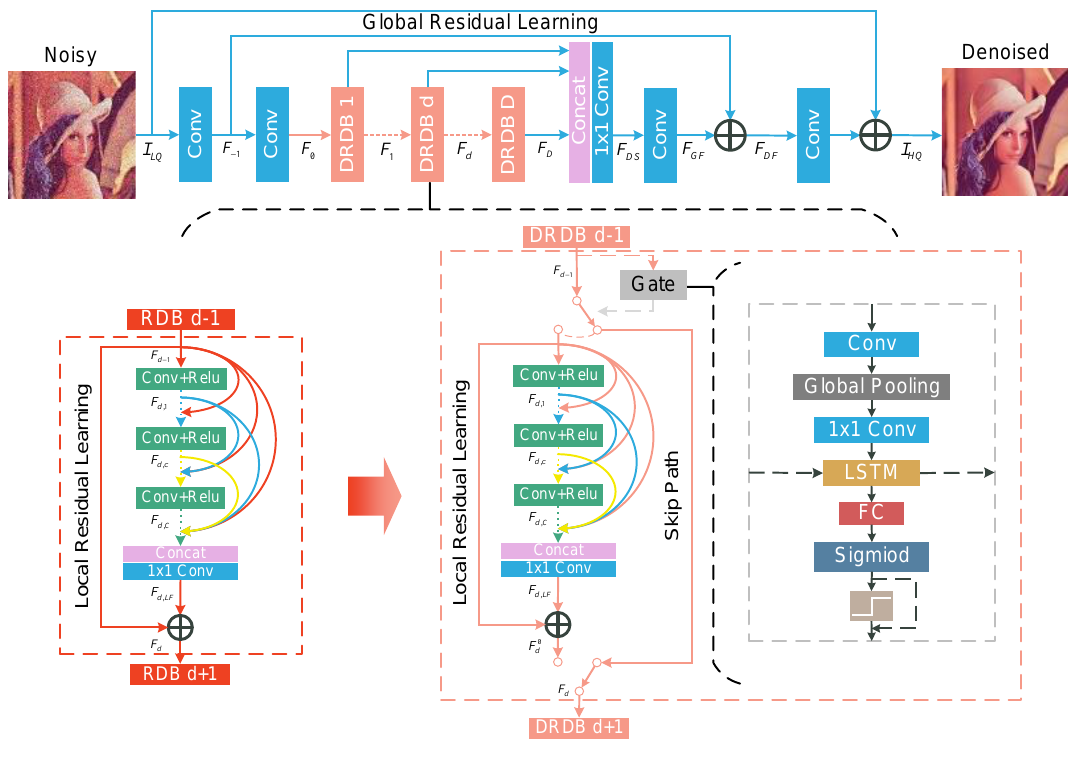
Figure 2. The top part presents the overall architecture of the DRDN. The bottom part shows the difference between the RDB and DRDB and how the gate module is inserted into the original